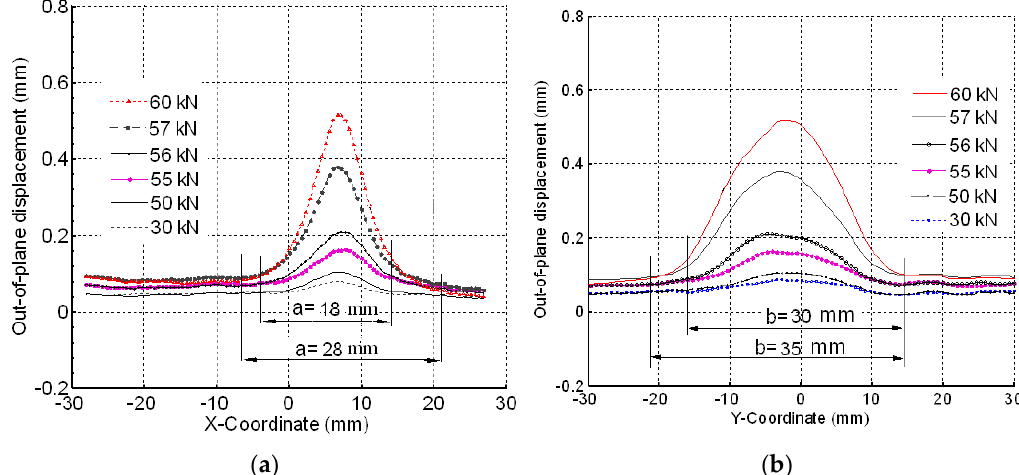
Figure 16. ( a ) Out-of-plane displacements seen when the vertical cut plane (B) of Figure 15b is used at different compression loads. ( b ) Out-of-plane displacements seen when horizontal cut plane (A) on Figure 15b is used at different compression load. (n.b. the curves were shifted slightly for clarity. In other words, the out-of-plane displacements were artificially increased to separate the curves from each other.)